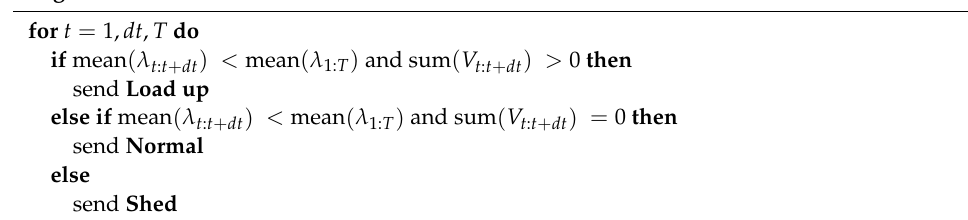
Algorithm 2 Rule-based